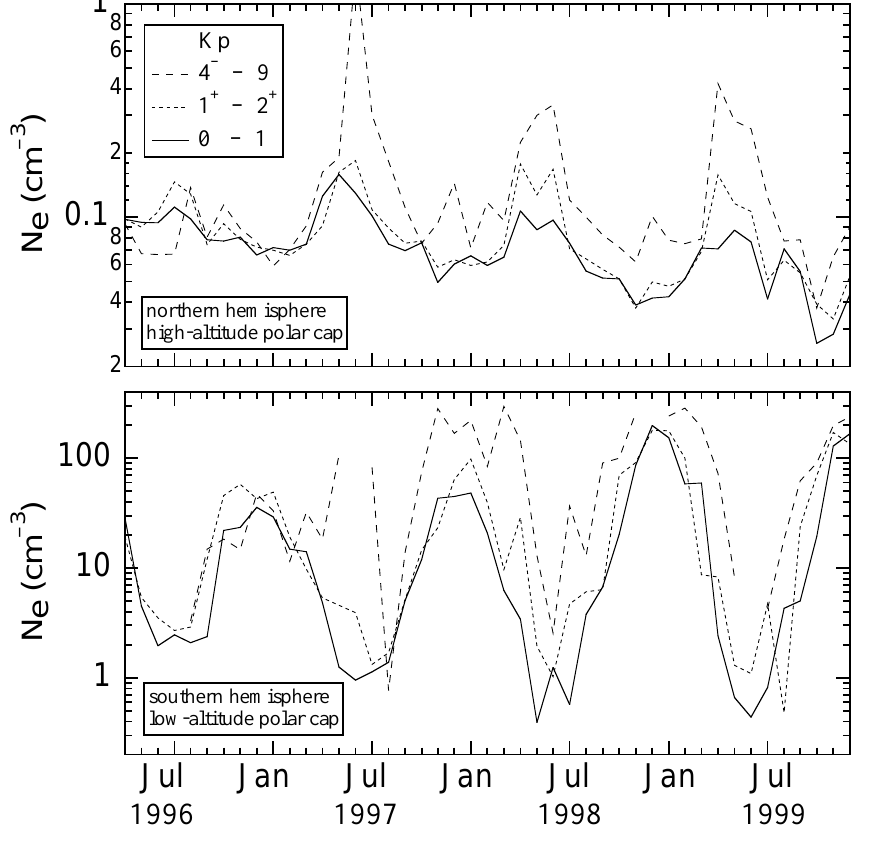
Fig. 5. The monthly averages of the electron density in the polar cap region over the Southern Hemisphere (upper panel) and the Northern Hemisphere (lower panel). The measurements in different geomagnetic conditions are separated: solid lines are for quiet con- ditions, dotted lines for moderately ac- tive conditions, and dashed lines for dis- turbed conditions. Note the different density scales between the two